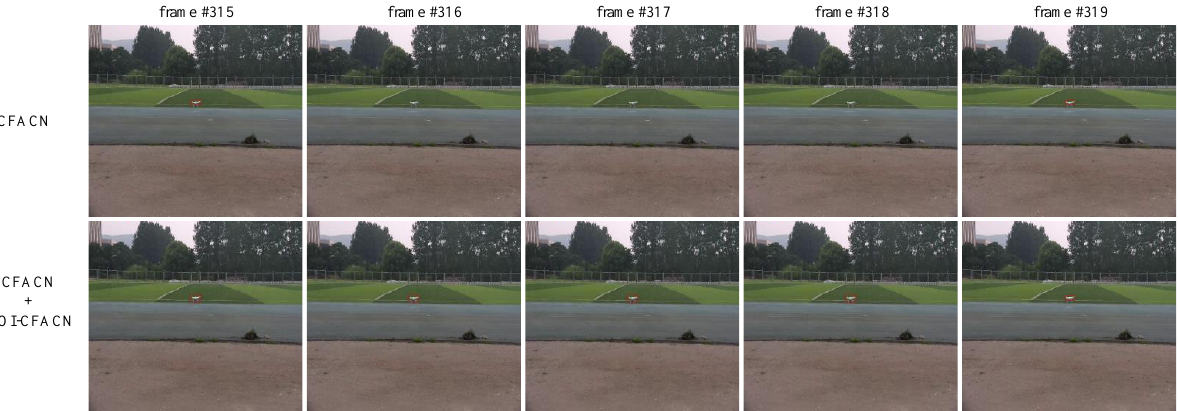
Figure 11. Comparison of CFACN detector and the proposed detection and tracking method [CFACN +